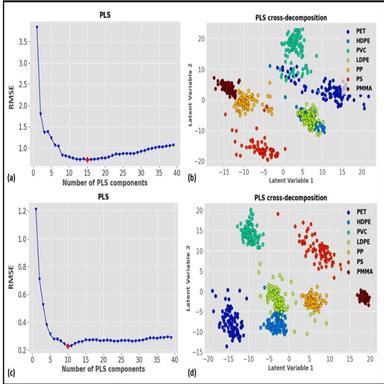
(a) RMSE vs. PLS component number plot for PLS decomposition of LIBS data from plastics, (b) PLS score pot for the LIBS data collected from 7 plastic classes, (c) RMSE vs. PLS component number plot for PLS decomposition of Raman data from plastics, and (d) PLS score pot for the Raman data collected from 7 plastic classes.